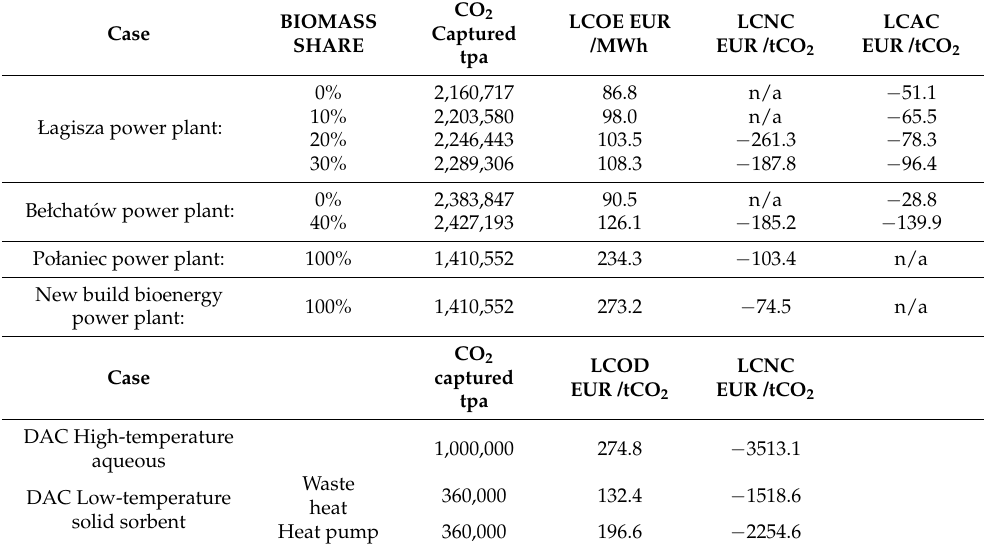
Table 10. Summary of economic evaluation.